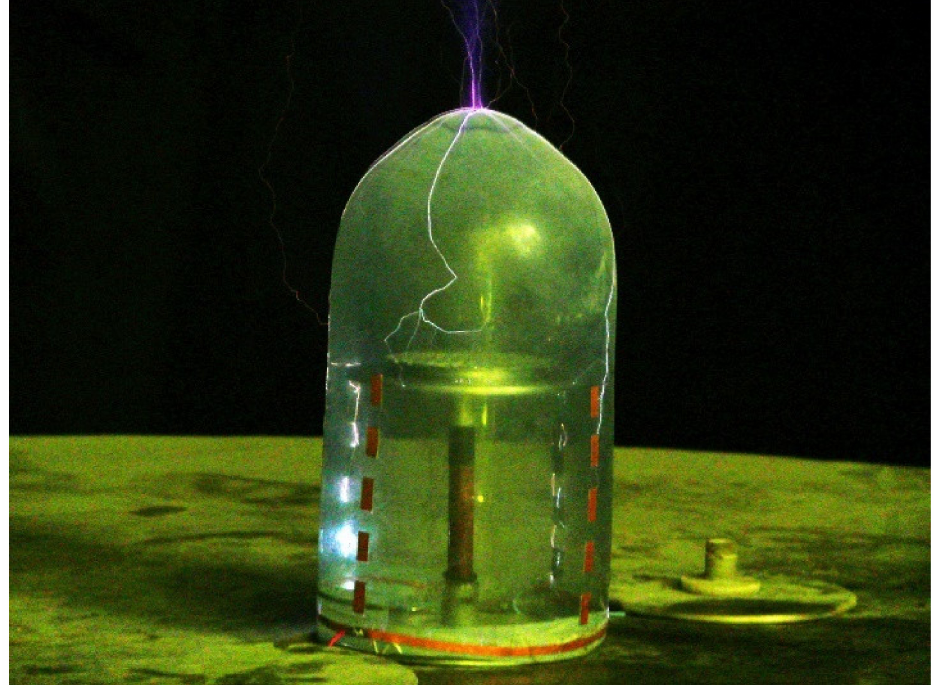
Figure 8. Discharge formation in radome model in the presence of segmented electrodes on its outer